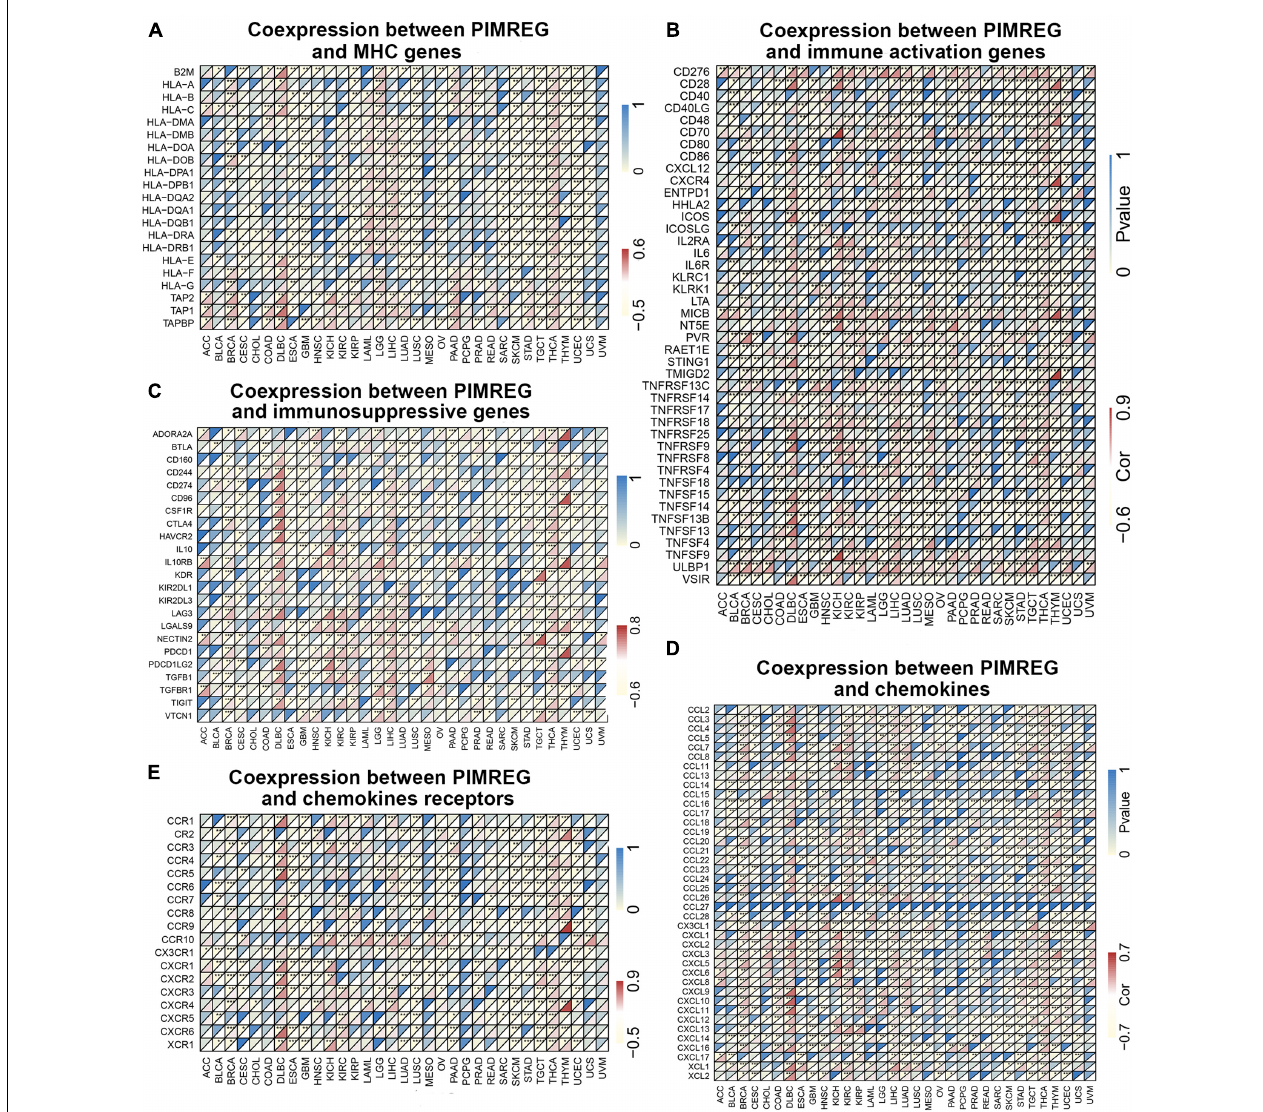
FIGURE 13 | Co-expression of PIMREG with immune-associated genes. * p < 0.05, ** p < 0.01, and *** p < 0.001. Coexpression between PIMREG and (A) MHC genes, (B) immune activated genes, (C) immunosuppressive genes, (D) chemokines, (E) chemokines